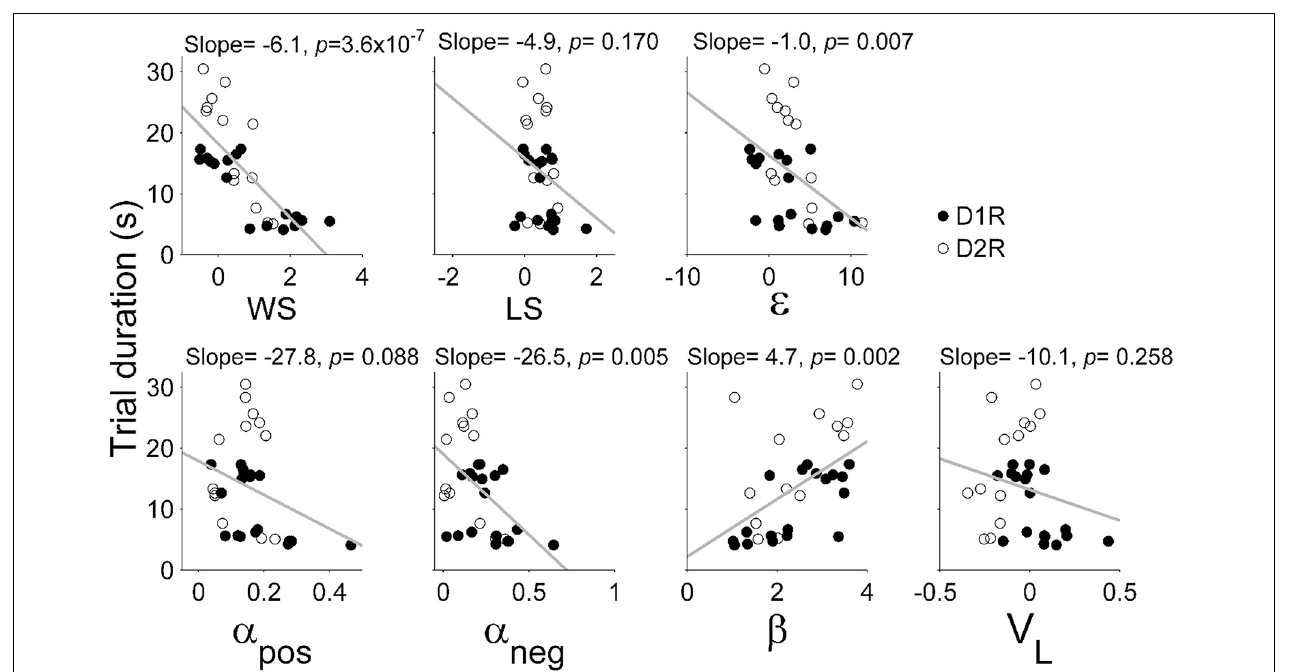
learning rate for negative outcome; β , inverse temperature indicating randomness in action selection; V L , choice bias toward the left goal. All animals tested in the TAB task were included in the